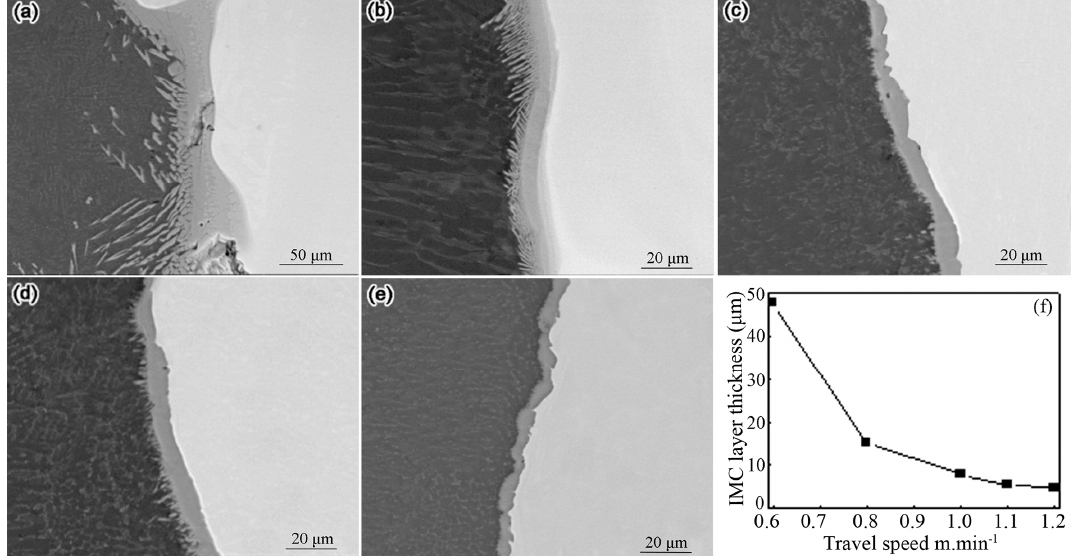
Figure 10. IMC layer microstructures at the interface of the Al/steel butt joints with different travel speeds: ( a ) 0.6 m/min; ( b ) 0.8 m/min; ( c ) 1.0 m/min; ( d ) 1.1 m/min; ( e ) 1.2 m/min; ( f ) thickness of the IMC layers (contained in the second panel).